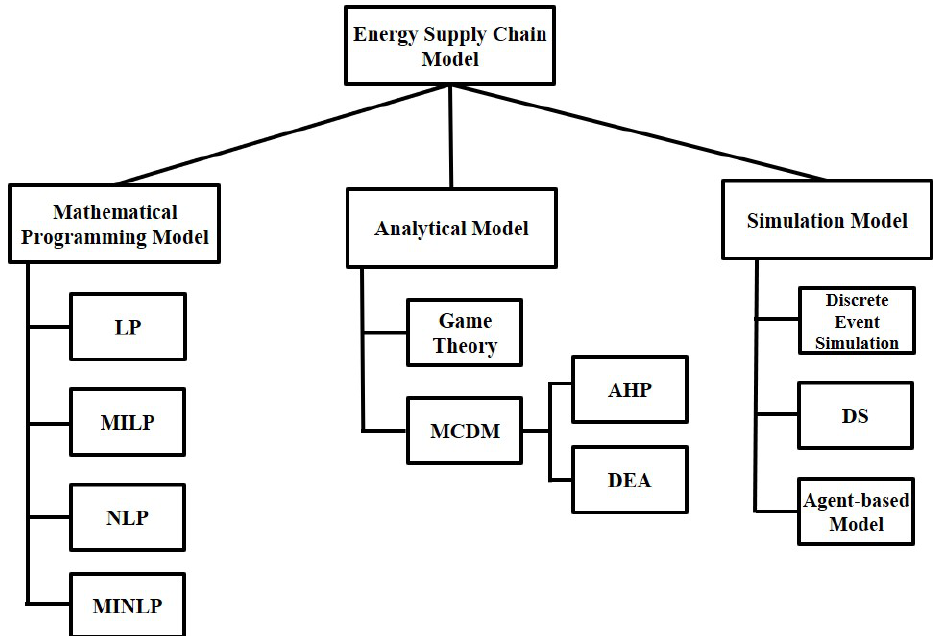
Figure 2. Energy supply chain